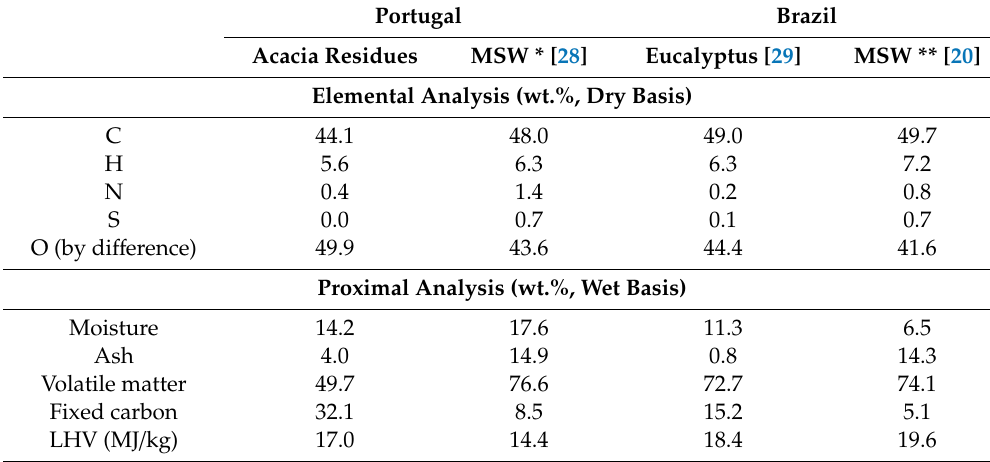
Table 3. Chemical composition of the used